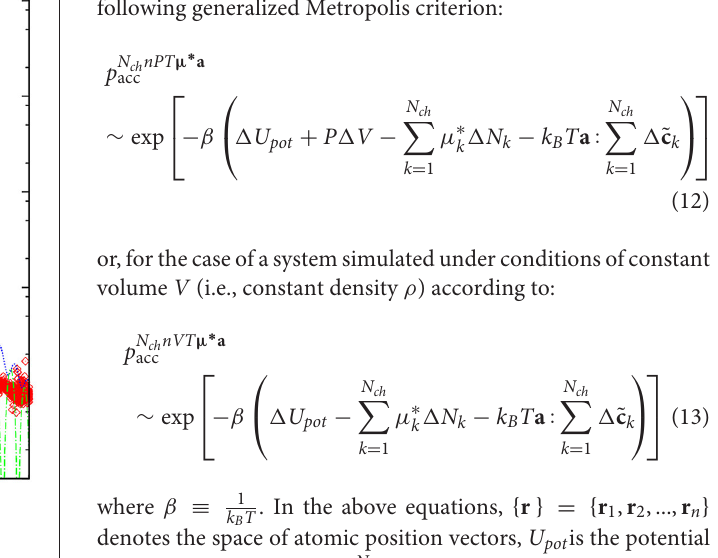
( S g ( q ) FIGURE 8 | Monte Carlo predictions for the scattering curve S g ( q ) n g ( N g + 1 ) denotes the corona structure factor, n g the number of grafted chains on the nanoparticle, and N g the length of grafted chains in Kuhn segments) of a system consisting of an 8 nm-radius silica nanoparticle on the surface of which atactic polystyrene chains of molecular weight equal to 20 kg/mol have been grafted at surface density equal to 0.5 nm − 2 . The grafted corona is inside a 100 kg/mol atactic polystyrene matrix. A piecewise cubic Hermite (PcH) spline interpolation scheme has been used. Results from two theoretical models [the form factor of a spherical shell of uniform density and thickness equal to the estimated brush thickness, and the model proposed by Pedersen and Gerstenberg [70] and Pedersen [71] for block copolymer micelles] are also included. Reprinted (adapted) with permission from Vogiatzis and Theodorou [ 69]. Copyright (2013) American Chemical